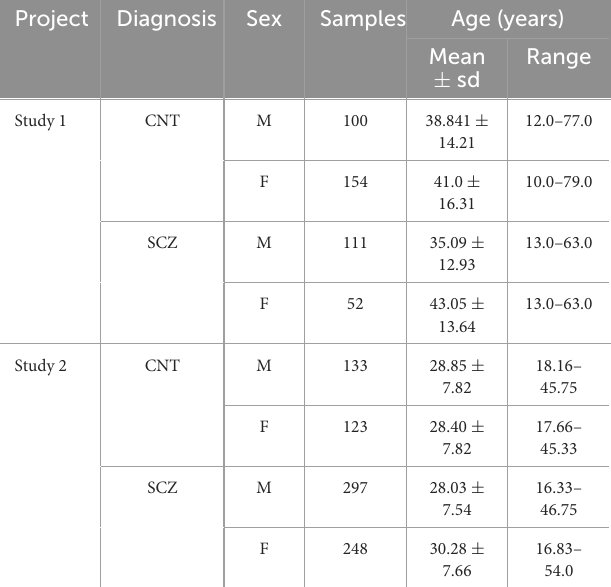
TABLE 1 Demographic information of